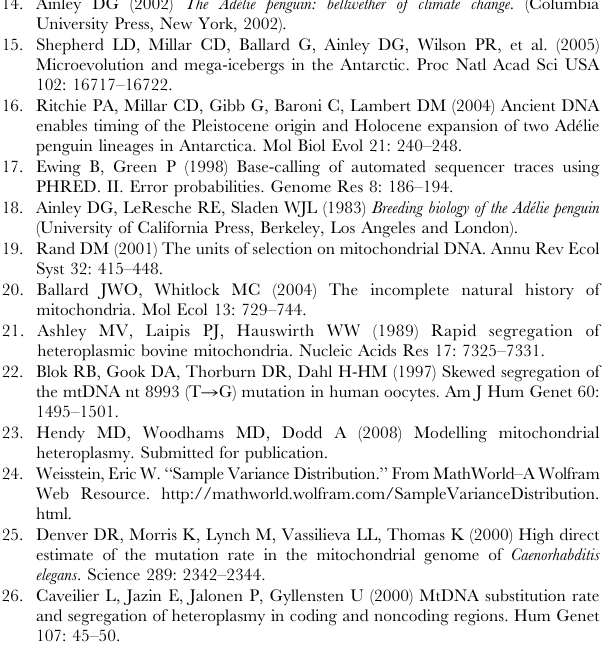
Table S3 Threshold